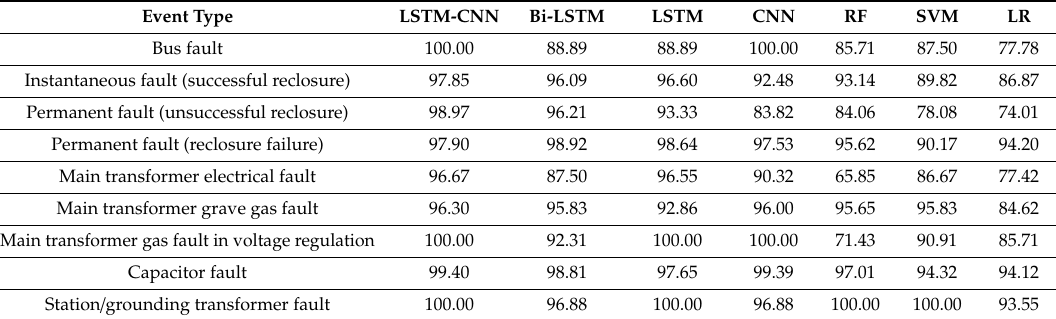
Table 9. Comparison of accuracy of this model with other models.